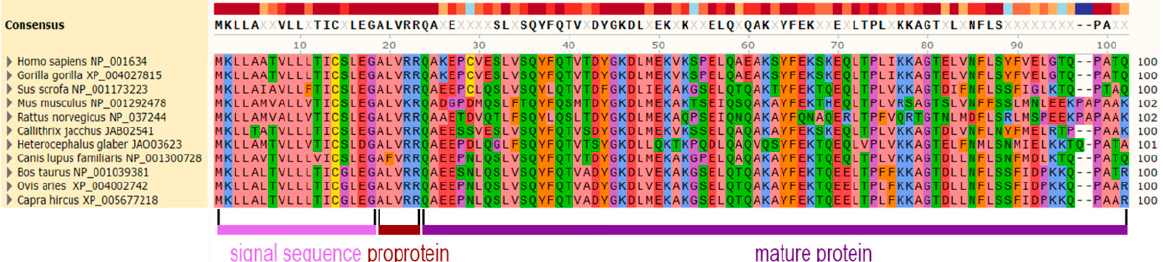
Figure 3. The alignment of apolipoprotein A-II preproprotein from various mammalian species. In the upper part, there is the consensus sequence with a threshold of 75%. The sequences are marked with the color highlighting the physicochemical properties of the amino acids. The alignment was performed using SnapGene—MUSCLE software version 3.8.1551 (GSL Biotech LLC, San Diego, CA, USA).